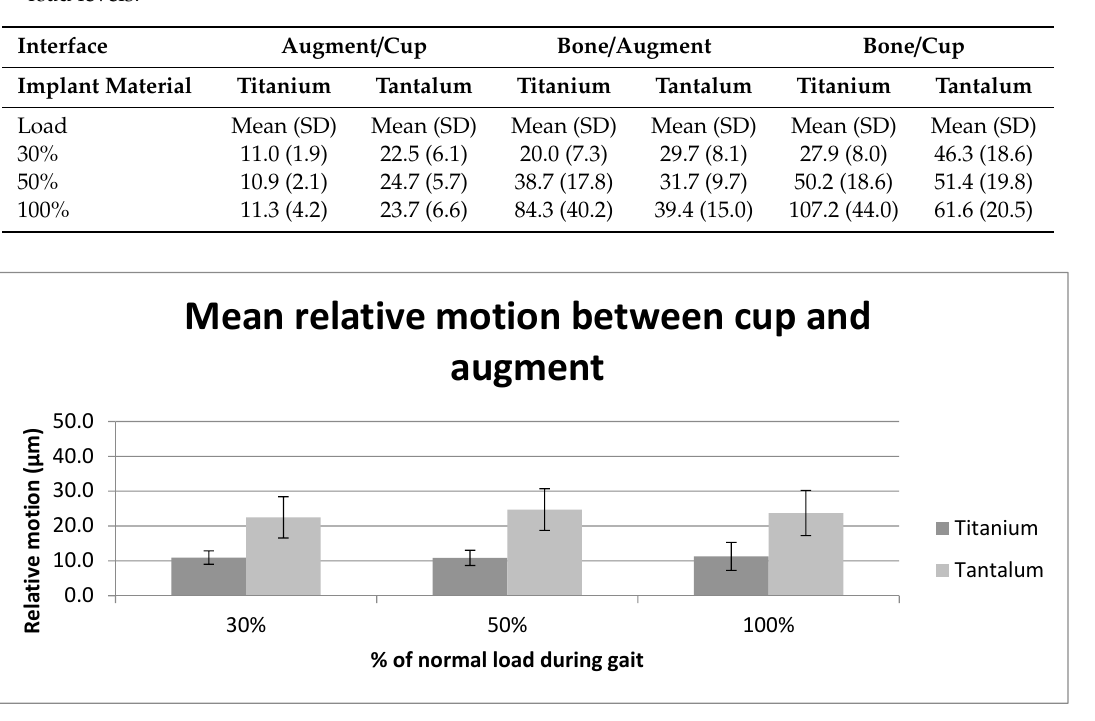
Figure 3. Graph displaying the average relative motion ( μ m) at the tantalum and titanium augment and cup interfaces at the three tested load levels (30%, 50% and 100% load).